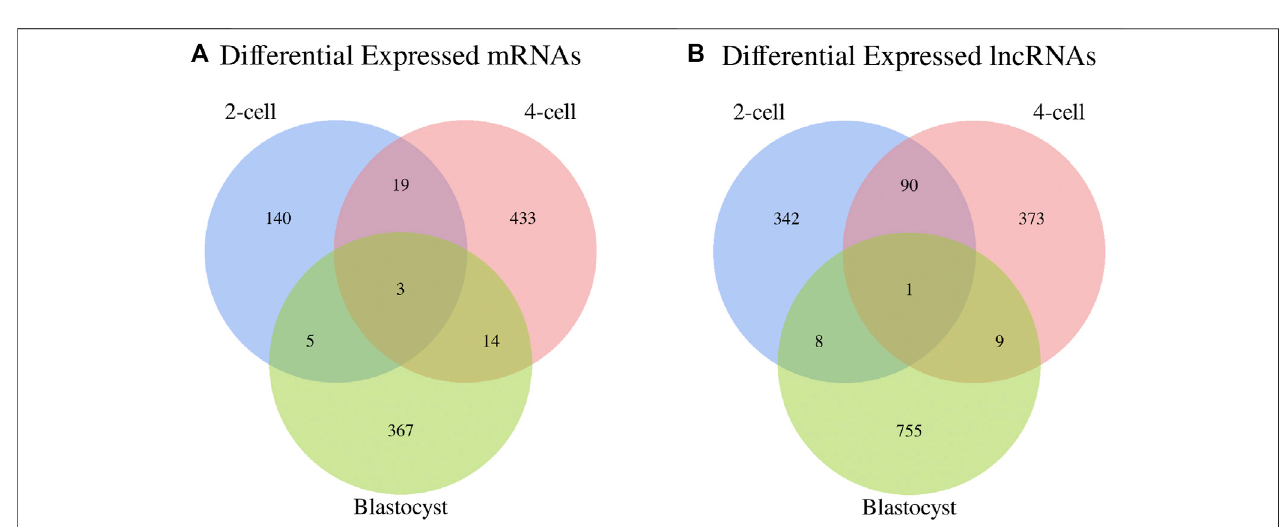
FIGURE 4 | Venn diagrams of differentially expressed (A) mRNAs and (B) lncRNAs among three libraries.